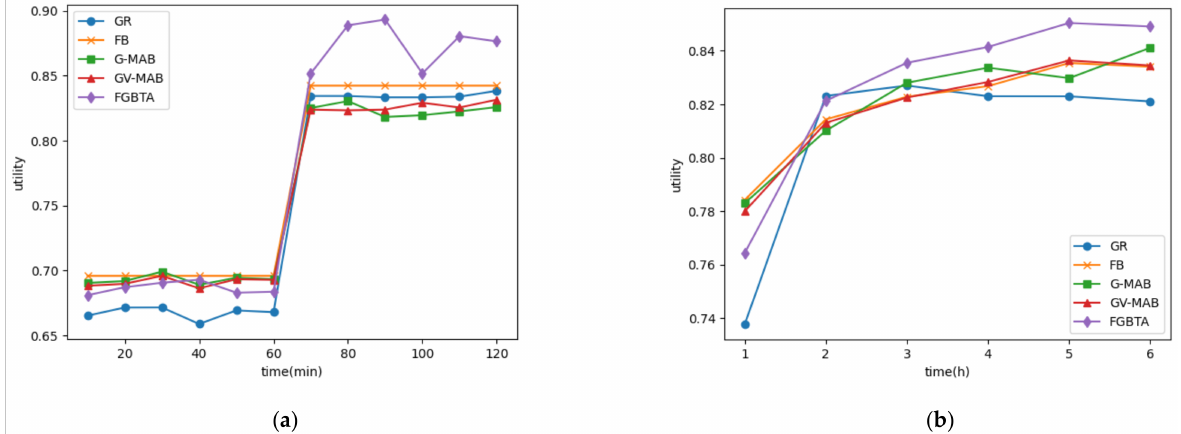
Figure 4. ( a ) The comparison of different algorithms in sudden drift; ( b ) the comparison of different algorithms in incremental